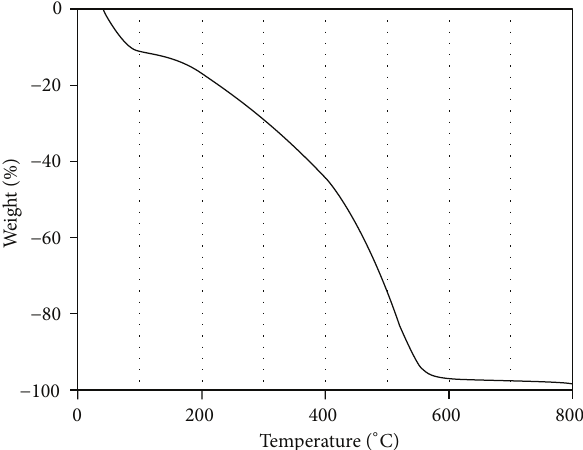
Figure 4: Thermogravimetric spectrum under 20% oxygen flow with a temperature ramp rate of 10 ∘ C/min.